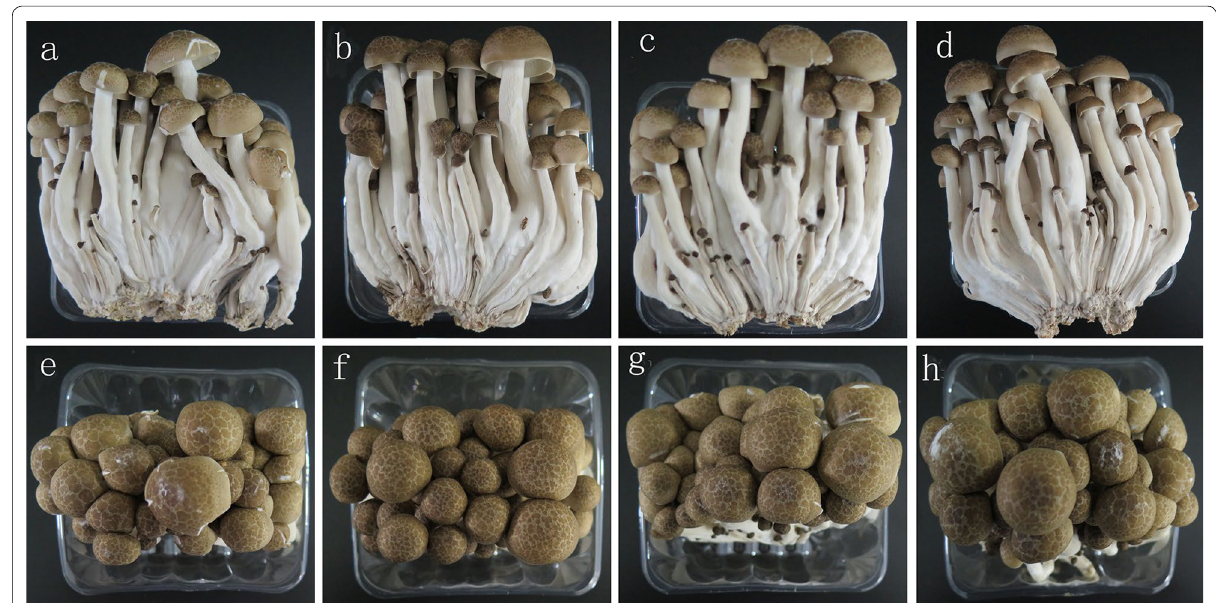
Fig. 1 Effects of HRW on sensory quality of Hypsizygus marmoreus after 12 days of storage. a , e Control group; b , f 25% HRW; c , g 50% HRW; d , h